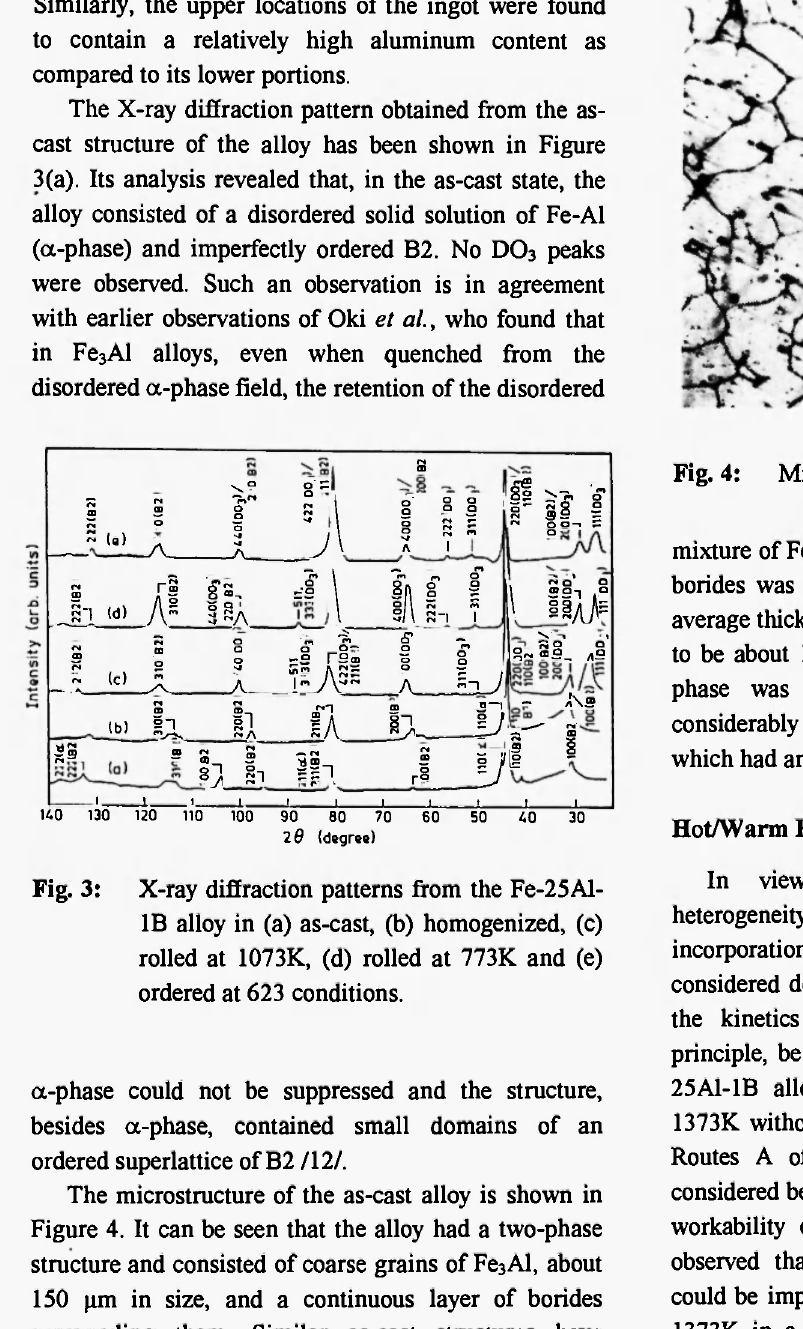
Fig. 4: Microstructure of the as-cast alloy. mixture of Fe B and Fe B. The volume fraction of iron 3 2 borides was found to be approximately 15% and the average thickness of the continuous layer was estimated to be about 15 μηι. The micro-hardness of the boride phase was found to be 650 VHN, which was considerably higher than that of the grain interior which had an average value of 460